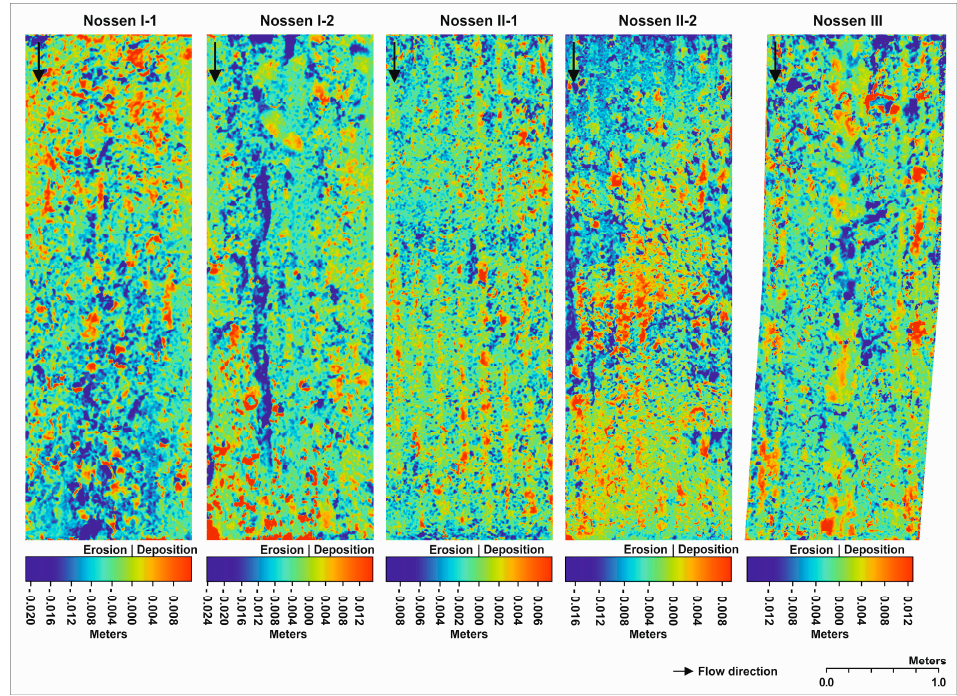
Figure 7. The DoDs of the plots in the resolution of 1 × 1 mm.